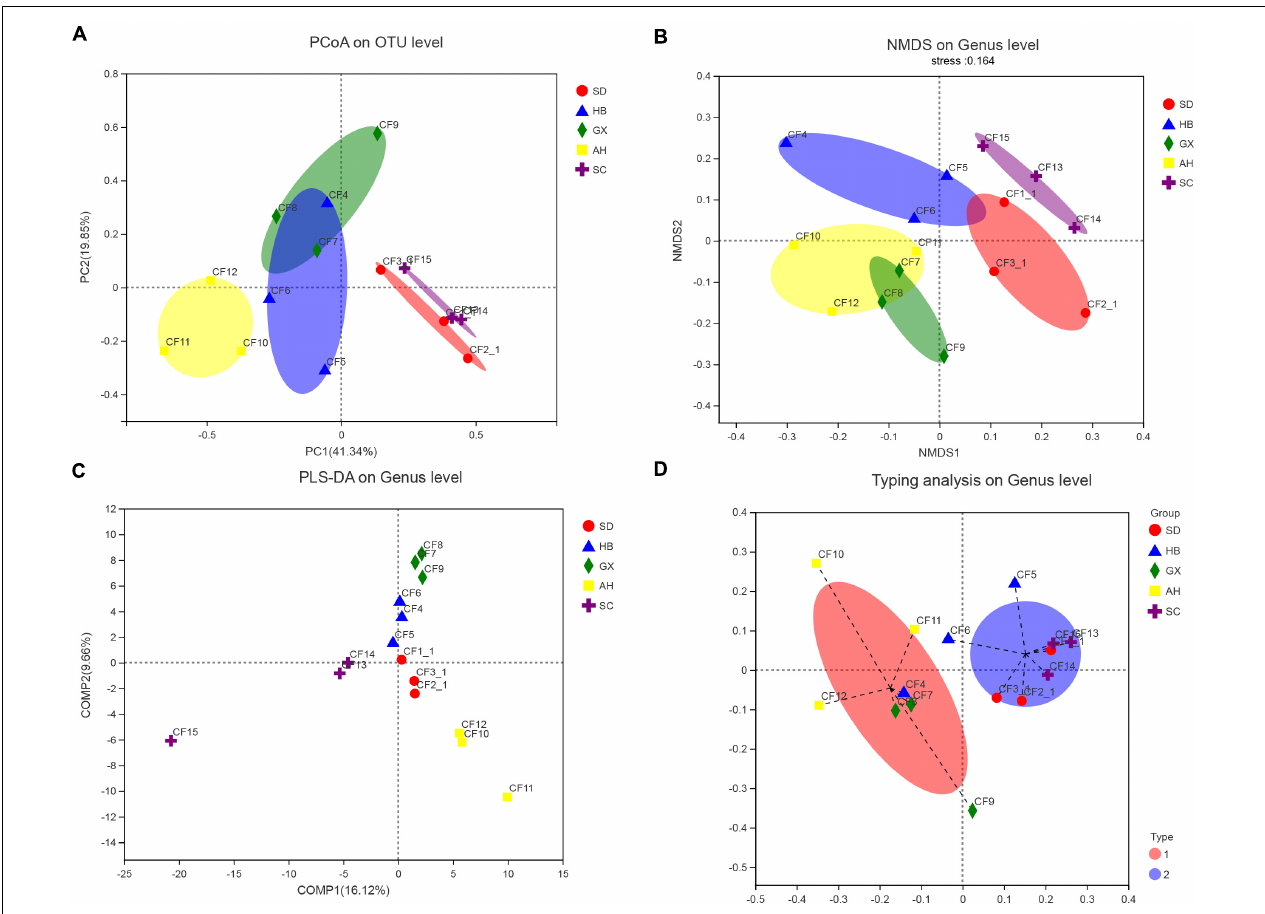
FIGURE 5 | Analysis of the beta diversity of the fungal community in groups based on collection areas. (A) Principal coordinates analysis (PCoA) plot on OTU level, (B) non-metric multidimensional scaling (NMDS) plot on genus level, (C) Partial least squares discriminant analysis (PLS-DA) plot on genus level, and (D) typing analysis on genus